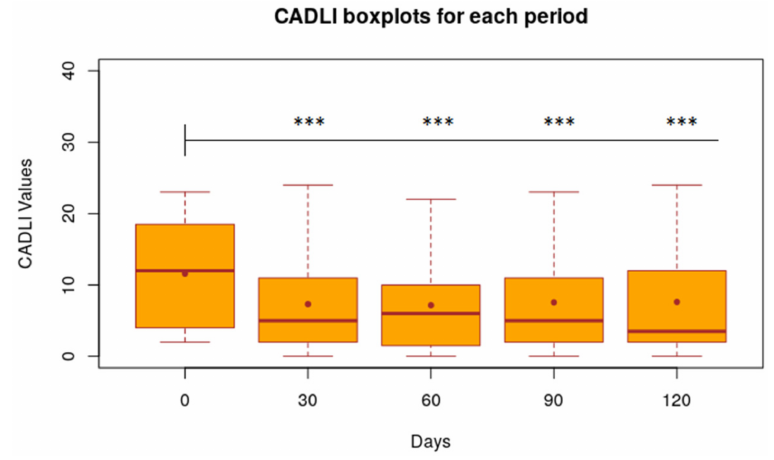
Figure 3. Statistical results of CADLI values calculated for each period, Boxplot of CADLI value of